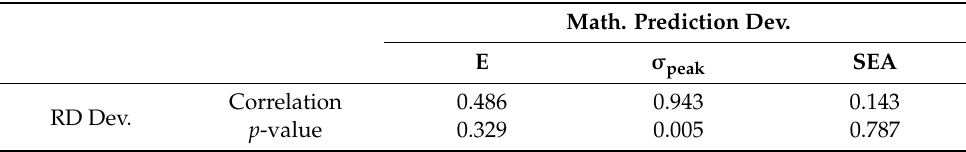
Figure 20. Relationship between RD absolute percent deviation, RD contribution, and mathematical prediction absolute percent deviation. Table 17. Correlation between RD absolute percent deviation and mathematical prediction absolute percent deviation of E, σ peak , and SEA.